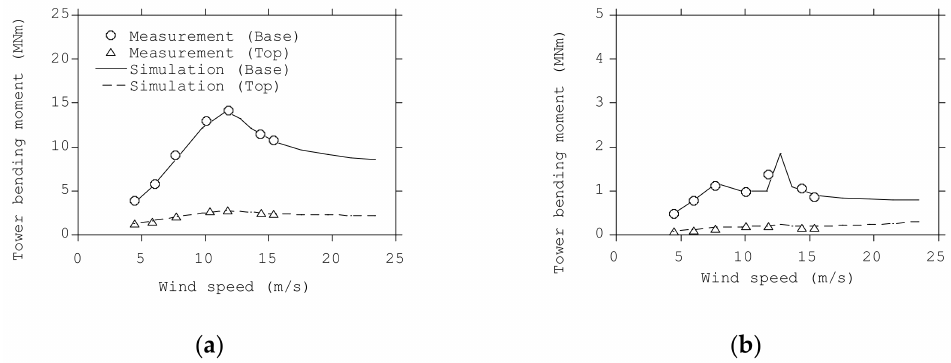
Figure 7. Effect of wind speed on ( a ) mean and ( b ) standard deviation of the fore-aft bending moment at the tower top and base.